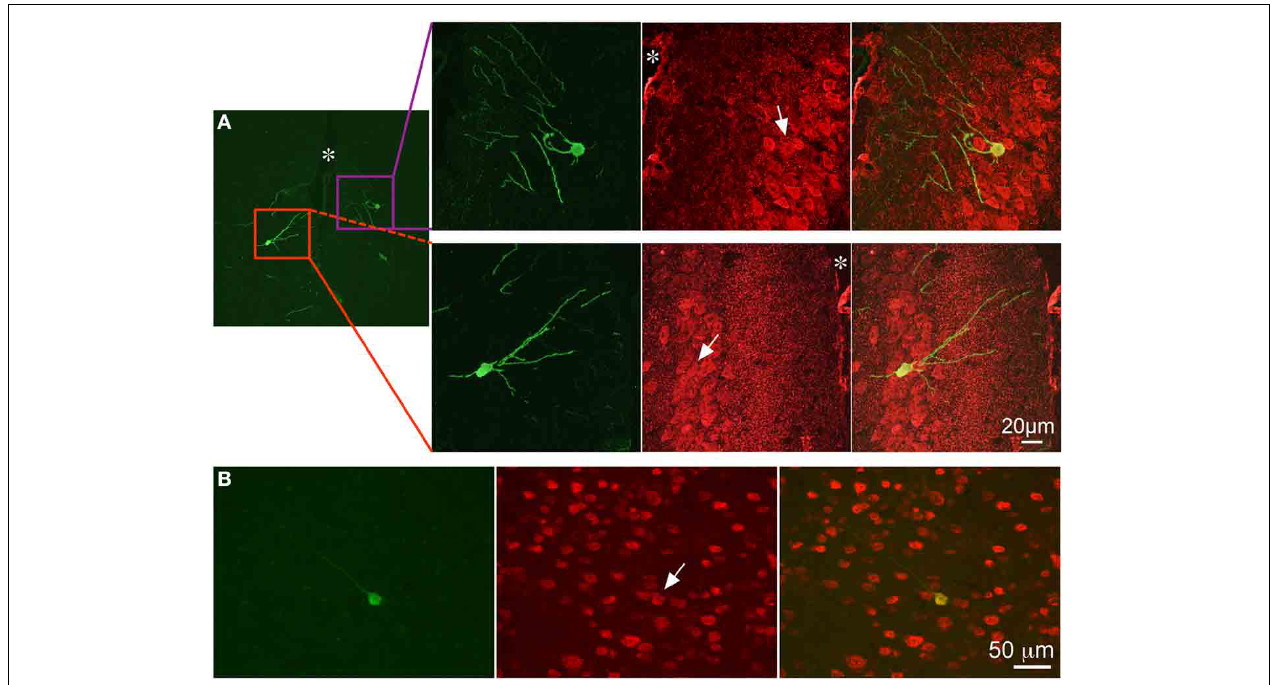
FIGURE 8 | GFP-ir in neocortex. Colocalization of GFP-ir (green) and NeuN-ir (red) in cingulate cortex ( A , ∗ indicates the location of the median fissure) and somatosensory cortex (B) . All arrows indicate GFP-positive neurons.